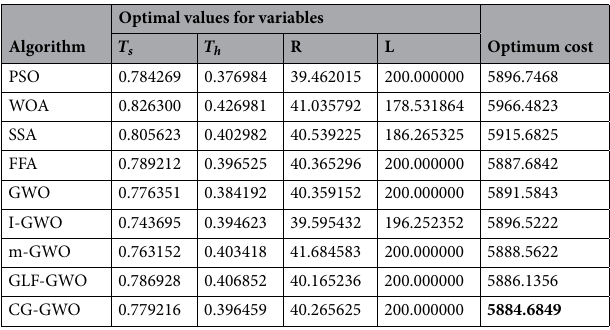
Table 8. Optimization results of the pressure vessel design problem. Significant values are in bold.